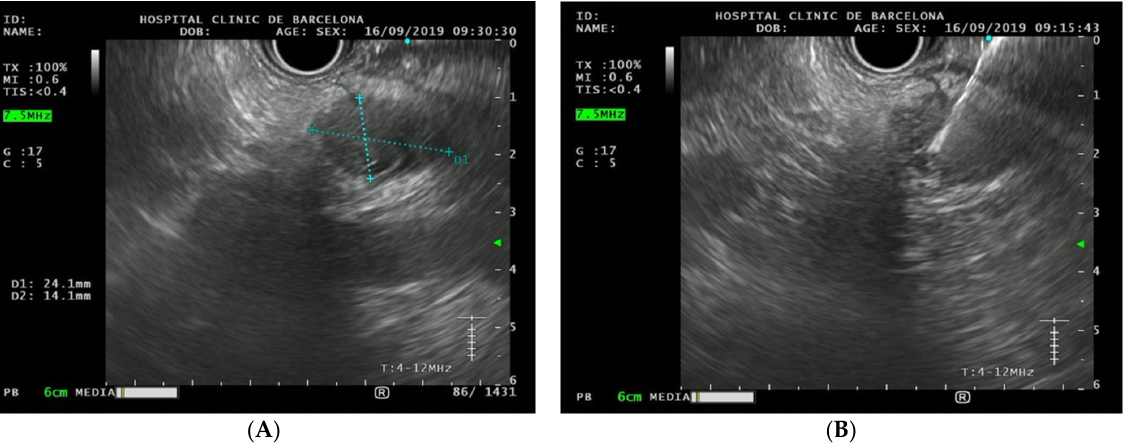
Figure 3. ( A ) Endoscopic ultrasound picture of the detected pancreatic cancer (24.1 × 14.1 mm). ( B ) Fine needle puncture in this operable tumor was performed and the cytology was positive for malignancy (adenocarcinoma). The final size was 28 × 16 mm (in the surgically removed piece). Regarding the other findings, all seven IPMN detected were small (<10 mm) and side ‐ branch IPMN without any high ‐ risk criteria. Of the three neuroendocrine tumors (NET), two were well ‐ differentiated tumors, confirmed by EUS ‐ guided fine needle aspiration with low (<2%) Ki ‐ 67 index (G1). In the third case, there was not enough histological sample and it was classified as a NET by the radiological characteristics. They presented a maximum diameter of 5, 16, and 7 mm, respectively; all three were considered low ‐ risk lesions. The five nonspecific cysts were all <10 mm and no other diagnostic tests were performed. Regarding the main pancreatic duct dilatation, it was a slight nonspecific dilation (5 mm) detected by EUS, with a normal previous MRI. In these last scenarios, a wait ‐ and ‐ watch strategy was adopted. All lesions remained stable and did not show any warning sign during follow ‐ up.